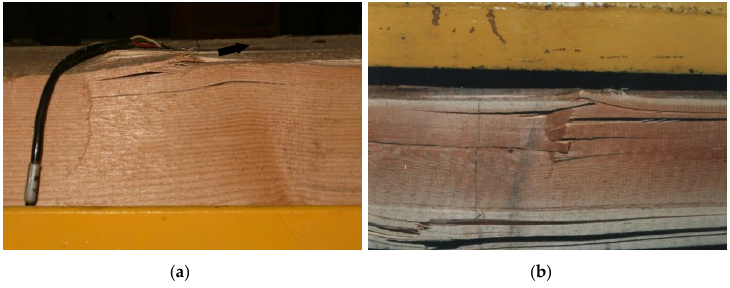
Figure 15. View of the wood plasticization in the compression zone in the initial phase of destruction( a ) and at the moment of beam failure( b